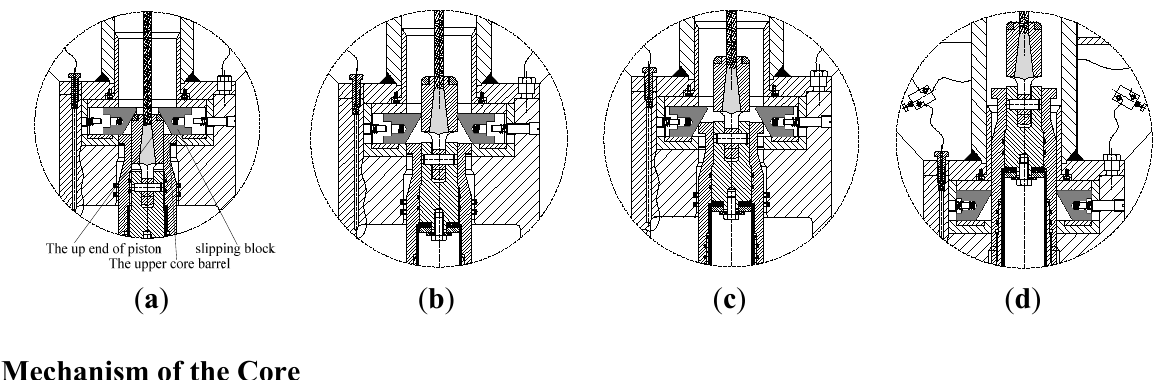
Figure 6. Moving sequence of the four spring bolts and piston: ( a ) The upper section of the piston touches the conical surfaces of the slip blocks of the spring bolts; ( b ) The spatial mounted four spring bolts are forced to move radially by the top end of the piston; ( c ) The four spring bolts are forced to move continuously by the dead weight of the core head, the pressure chamber and the mud-blocking unit; and ( d ) the whole barrels pass freely through the four spring